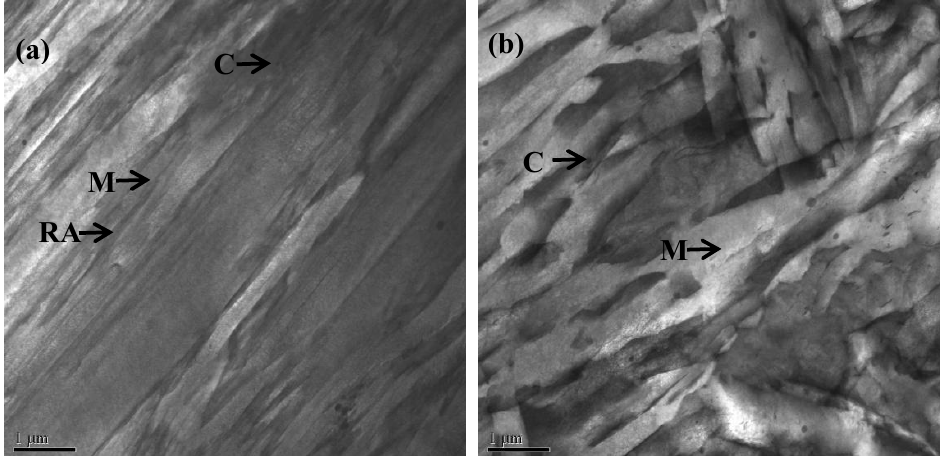
Figure 8. TEM image of the test steel with different martensite characteristics; ( a ) The partitioning time is 60 s with Q&P processing; ( b ) The relaxation time is 6 s with DP processing. M is martensite, RA is retained austenite and C is carbide.